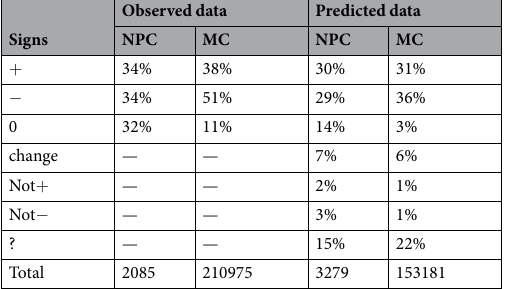
Table 1. Observed and predicted data repartition between NPC and MC. Observed data are the data extracted from the gene expression profiles. Predicted data are the sign projections predicted after the confrontation between the observed data and the PID-NCI graph. In the last row, we show the total observations and predictions across all